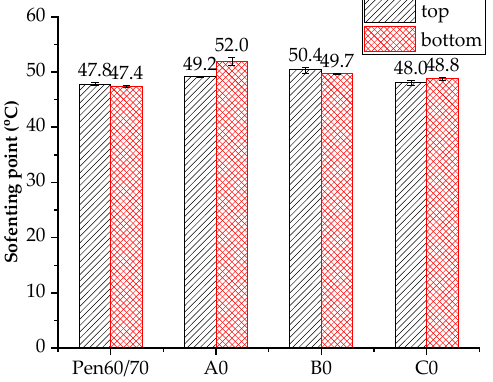
Figure 8. Storage stability of nanoclay modified bitumen.